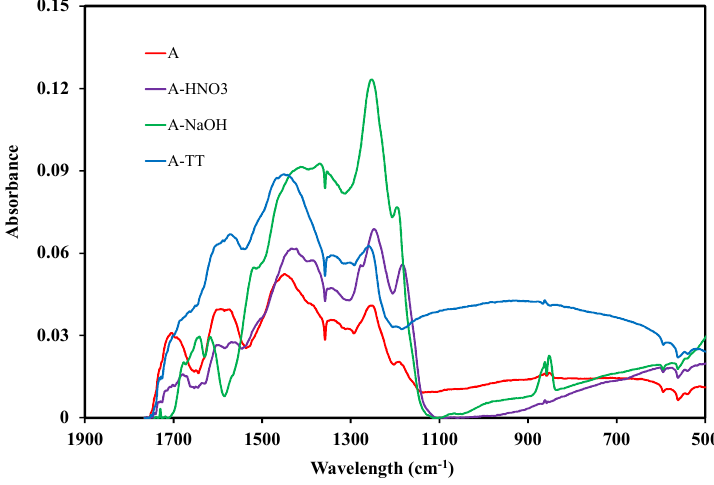
Figure 8. Fourier transformed infrared spectroscopy (FTIR) spectra of the different activated carbons